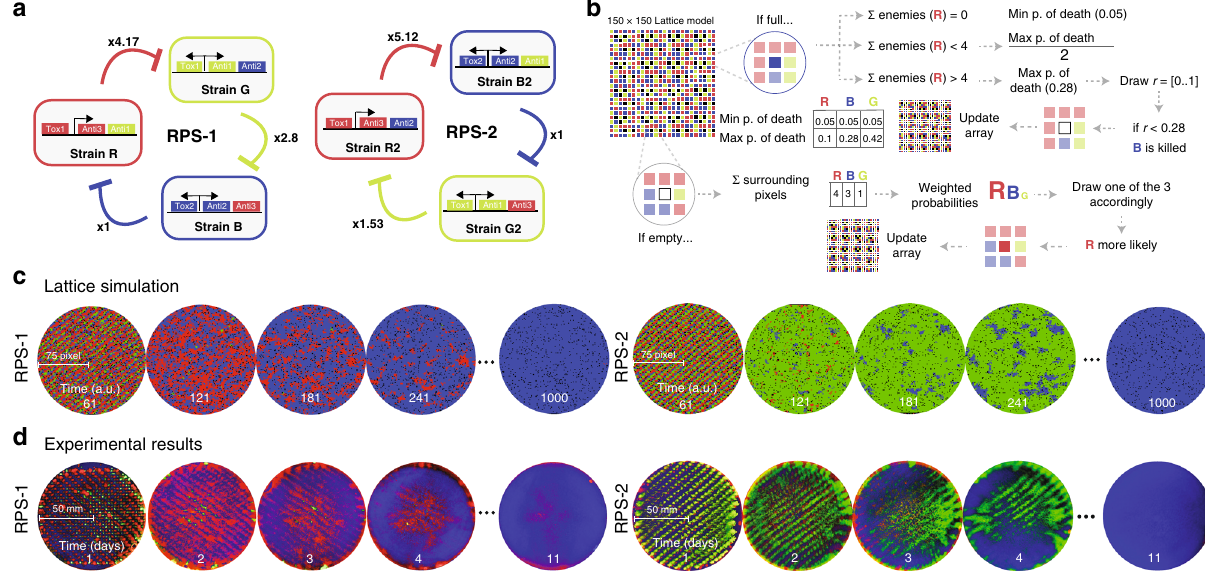
Fig. 3 Characterization of reversed RPS ecology and computational model. a Diagrams of RPS (RPS-1) and RPS reversed (RPS-2) in comparison. The numbers represent the relative toxin strength obtained from kill curve experiments. Source data are provided as a Source Data fi le. b Pseudocode illustrates the rules behind the lattice model simulations. c Comparison of model simulations of RPS-1 (left) to model simulations of RPS-2 (right) with a grid of density corresponding to 1536. d Comparison of experimental results of RPS-1 (left) to experimental results of RPS-2 (right) with density 1536. All lattice simulations plots were simulated in a square lattice grid and subsequently trimmed into circular shapes to ease the comparison with experimental results. This experiment was executed one time at this density and it was repeated at a lower density as shown in Supplementary Figs. 3 and competition of the three strains in a 150 × 150 square grid The simulations also con fi rmed our observation regarding the (Fig. 3b). With the parameter values established in our kill curve relationship between duration of coexistence and initial density experiments, simulations of our computational model agreed with (Supplementary Fig. 7). Furthermore, when simulating the RPS-2 our previous experimental results demonstrating that Strain B system, the model predicted that the eventual winner of the RPS should outcompete the other strains (Supplementary Movie 2). ecology would still be Strain B, con fi rming the idea of